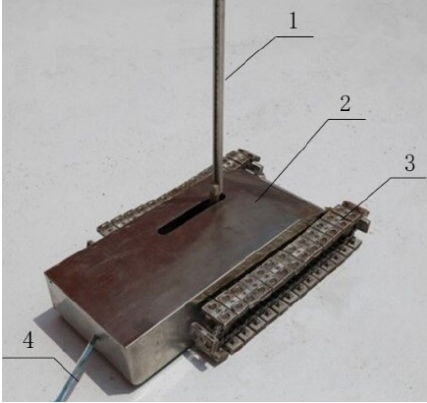
Figure 12. Overview of TWCR (1—scale, 2—main part of the robot, 3—tracks, 4—power supply cable).